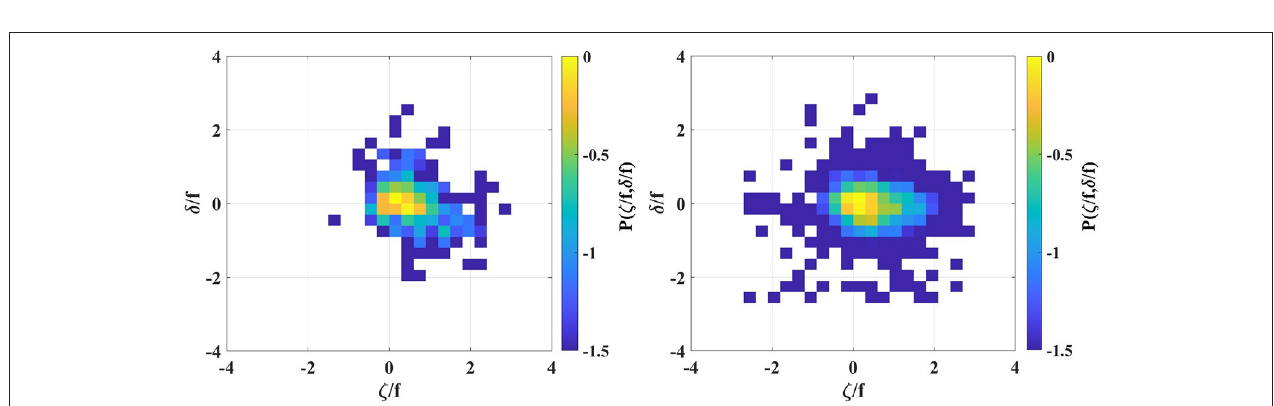
FIGURE 11 | Normalized joint probability distribution of divergence and vorticity (logarithmic scale) for surface drifters (CODE and CARTHE) in the range below 6 km for experiments 2018 (left) , and 2019 (right) .